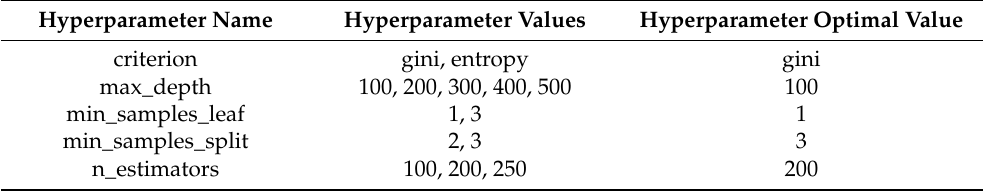
Table 7. Random Forest best hyperparameter combination after hyper-tuning.